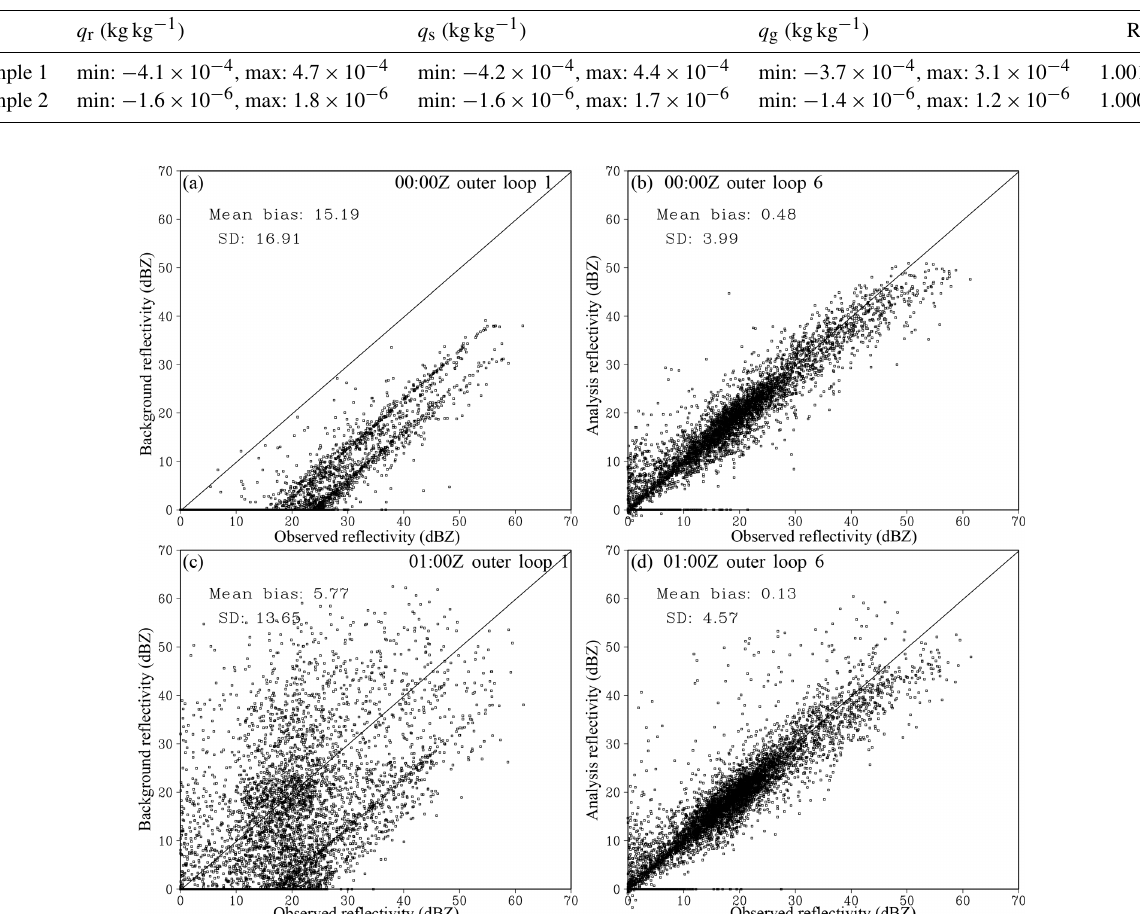
Figure 6. Scatter plots of the observed ( x axis) versus (a, c) background and (b, d) analysis reflectivity at (a, b) 00:00Z and (c, d) 01:00Z in Exp_ref. The mean bias and SD between the observations and the background (or analysis) are listed in each